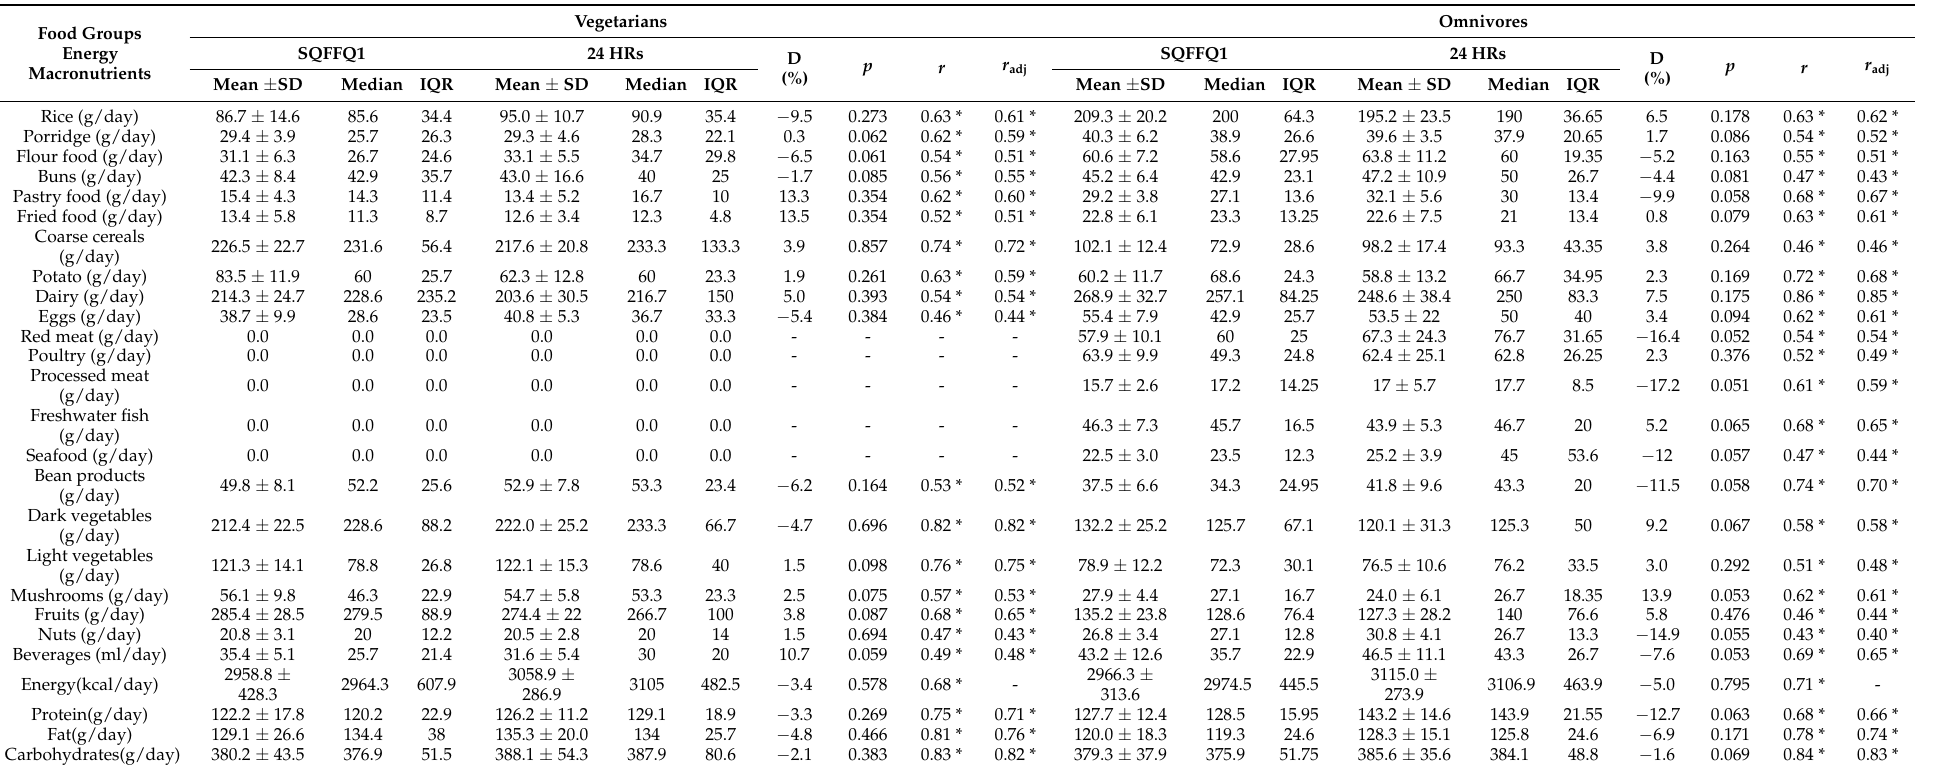
Table 4. Validity study: mean daily food intake, difference and correlation coefficients for the comparison between SQFFQ1 and 24